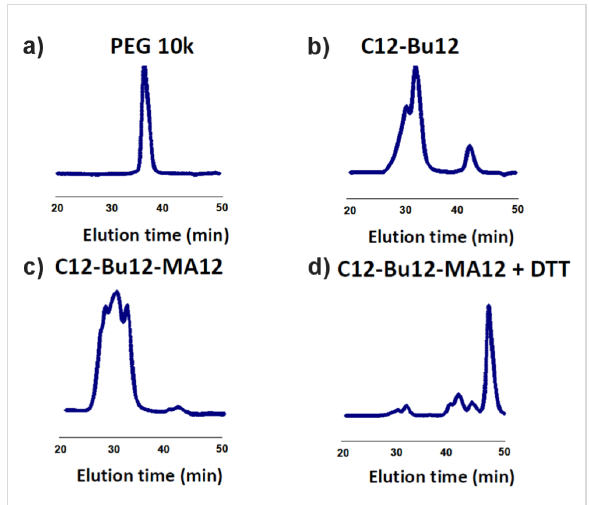
Figure 3: SEC analysis of the prepared polymers a) PEG 10 k, b) C12-Bu12, c) C12-Bu12-MA12, d) C12-Bu12-MA12 +